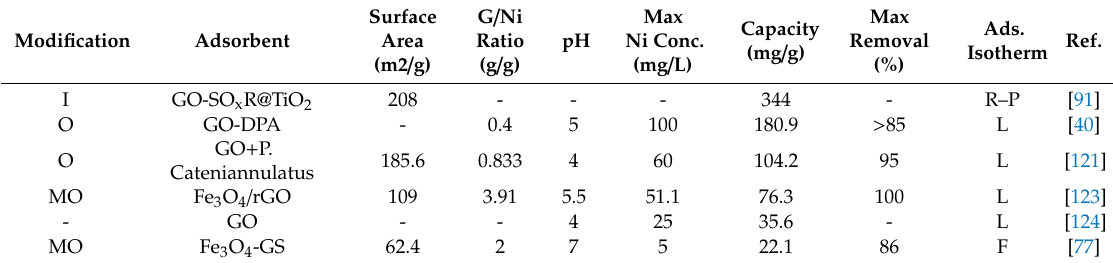
Table 5. Adsorption properties of multiple GO-based adsorbents used in Ni (II) removal.